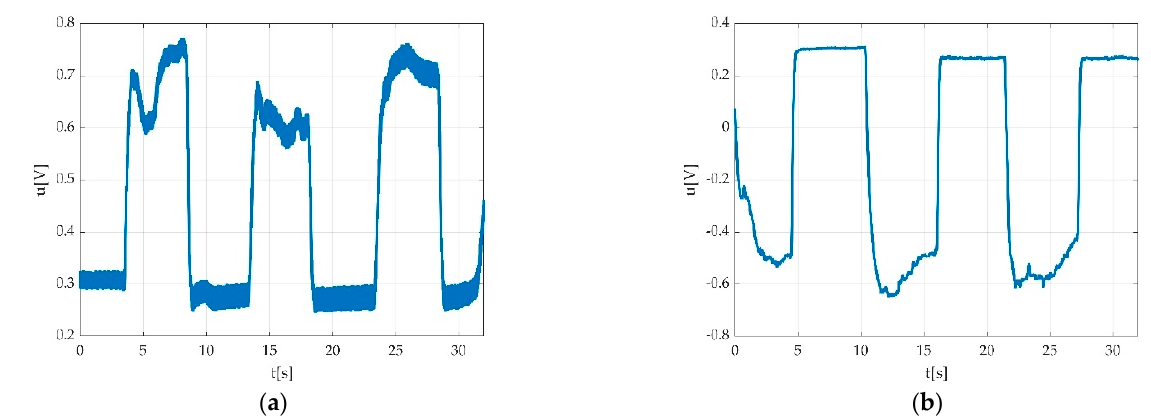
Figure 5. Example of the power supply network influence on the recorded signal: ( a ) PC running on battery; ( b ) PC running while connected to power supply network.